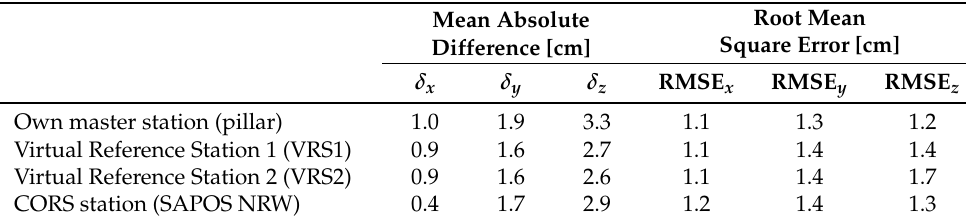
Table 5. Target center difference between TLS reference and UAV point cloud with four different GNSS master stations. The difference is described using the mean value and standard deviation for the East, North and height